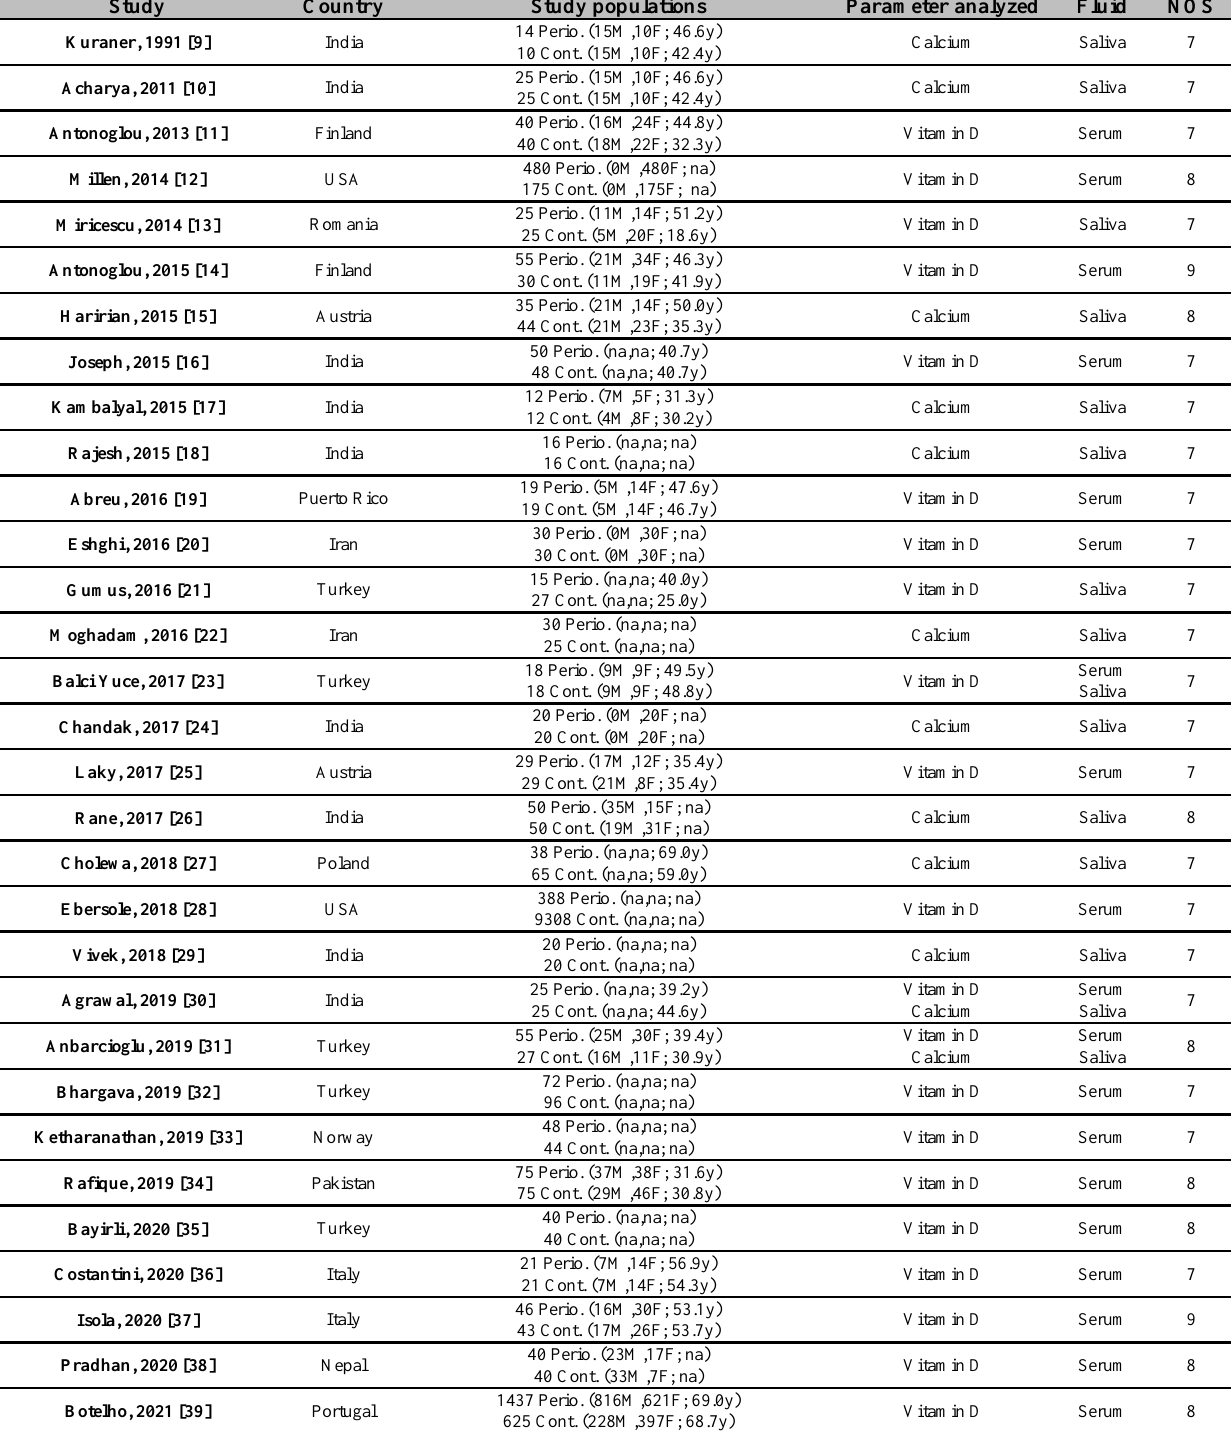
Table 1: Descriptive characteristics and methodological quality evaluation of the thirty-one articles included in this